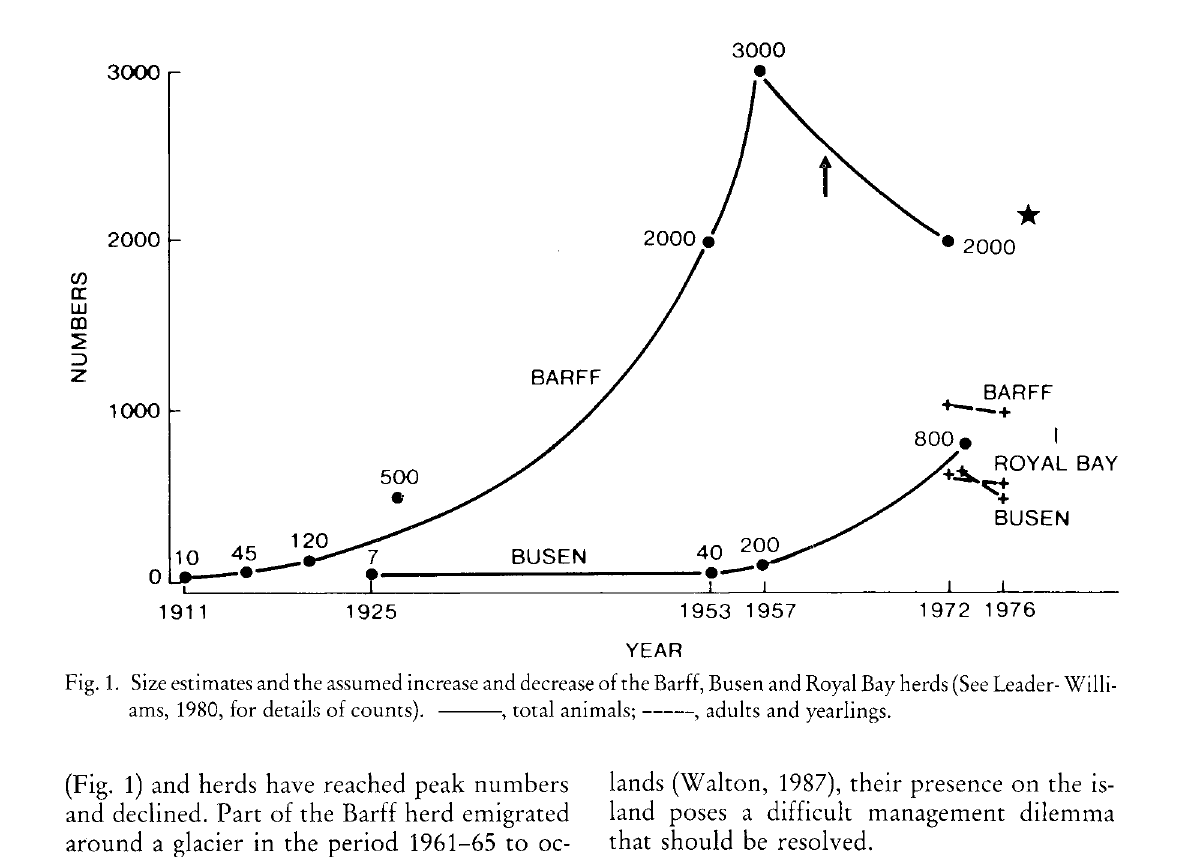
Fig. 1. Size estimates and the assumed increase and decrease of the Barff, Busen and Royal Bay herds (See Leader- Willi ams, 1980, for details of counts). , total animals; , adults and